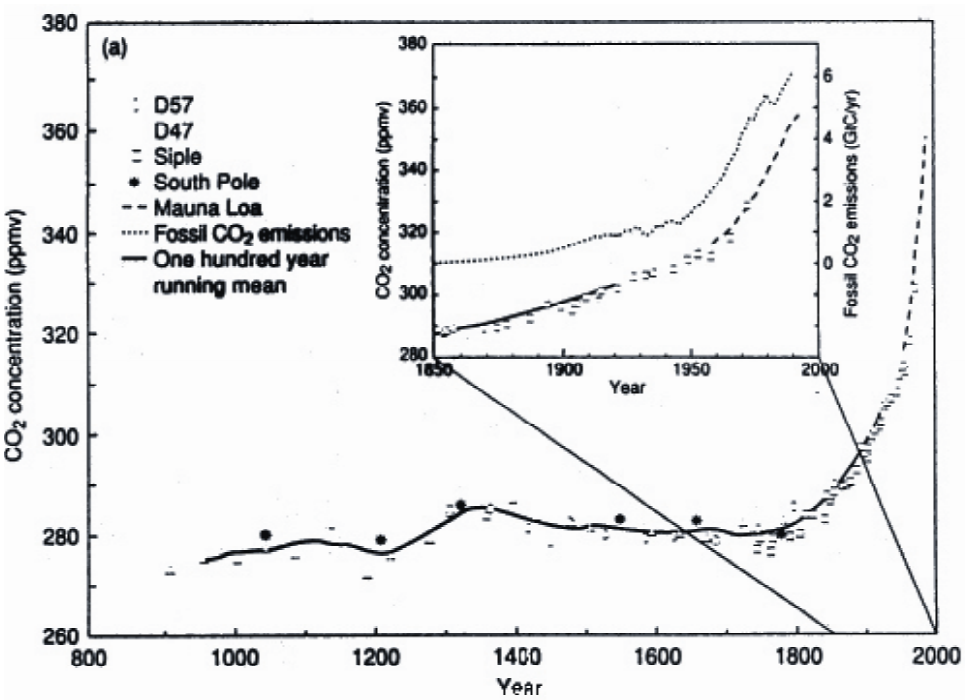
FIGURE 1. Atmospheric concentration of CO 2 compared with fossil